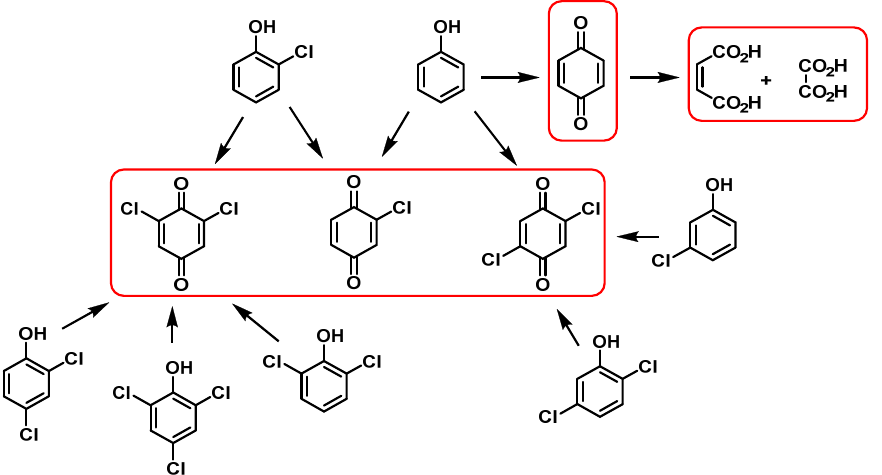
The main products of the oxidation of phenols with chlorine dioxide are p-benzoquinone and various substituted chloro-p-benzoquinones [80]. The chlorophenols are oxidized to the corresponding quinones. With a large excess of ClO 2 , the p-quinone is oxidized with ring cleavage, forming dicarboxylic acids. Oxidation of phenols and chloro-phenols [81] is shown in Figure 29.